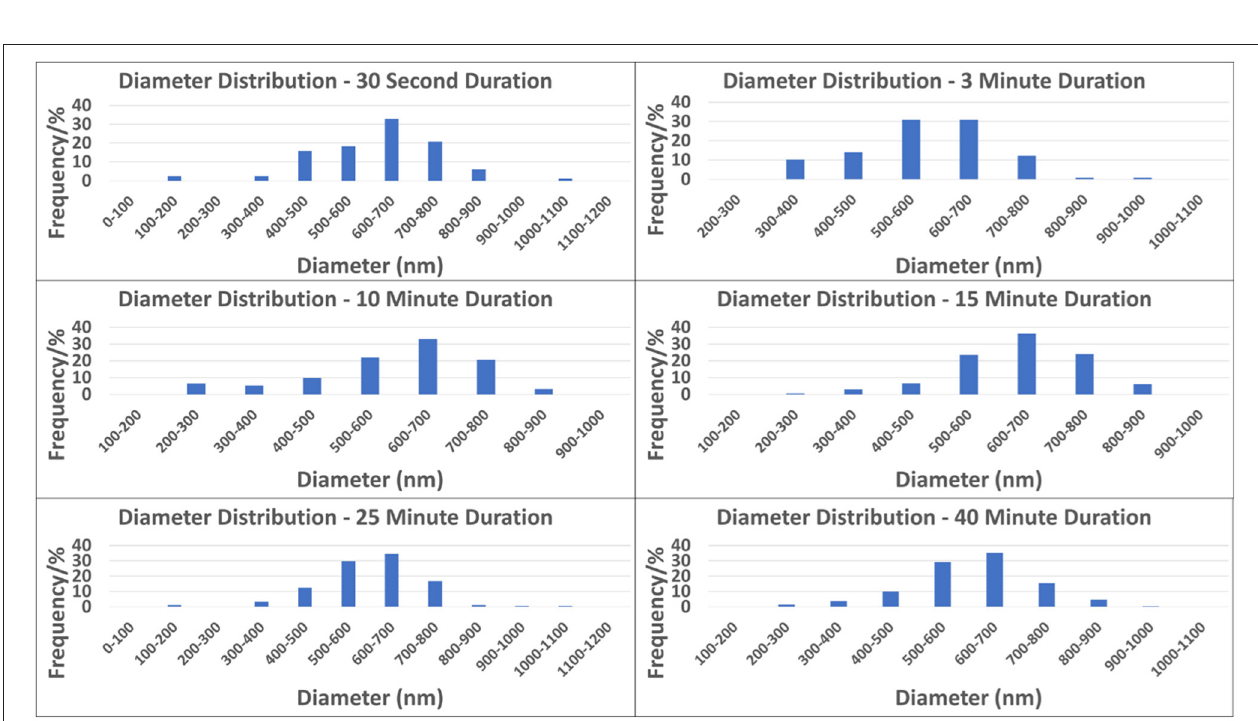
FIGURE 3 | Diameter distributions by each of the electrospinning durations.